Question: What form of chart is displayed?
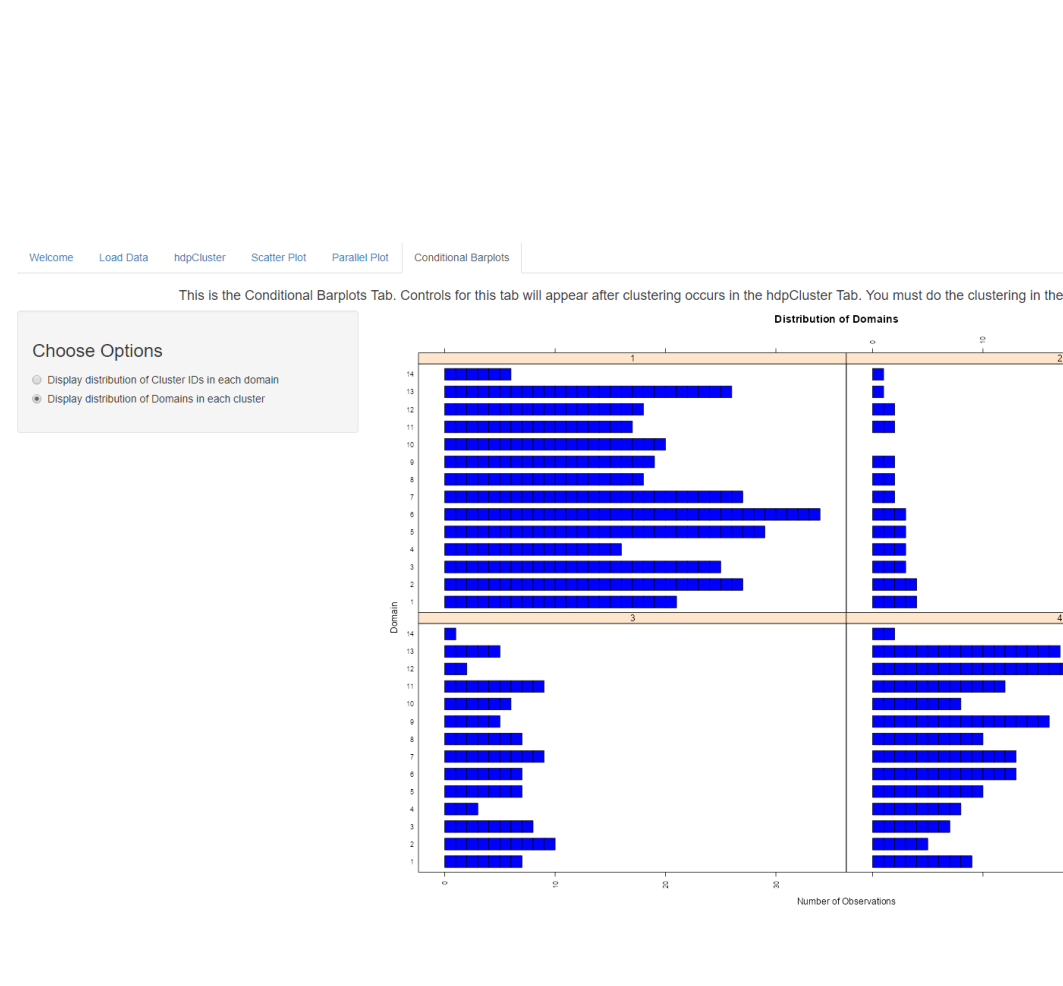
Answer: bar